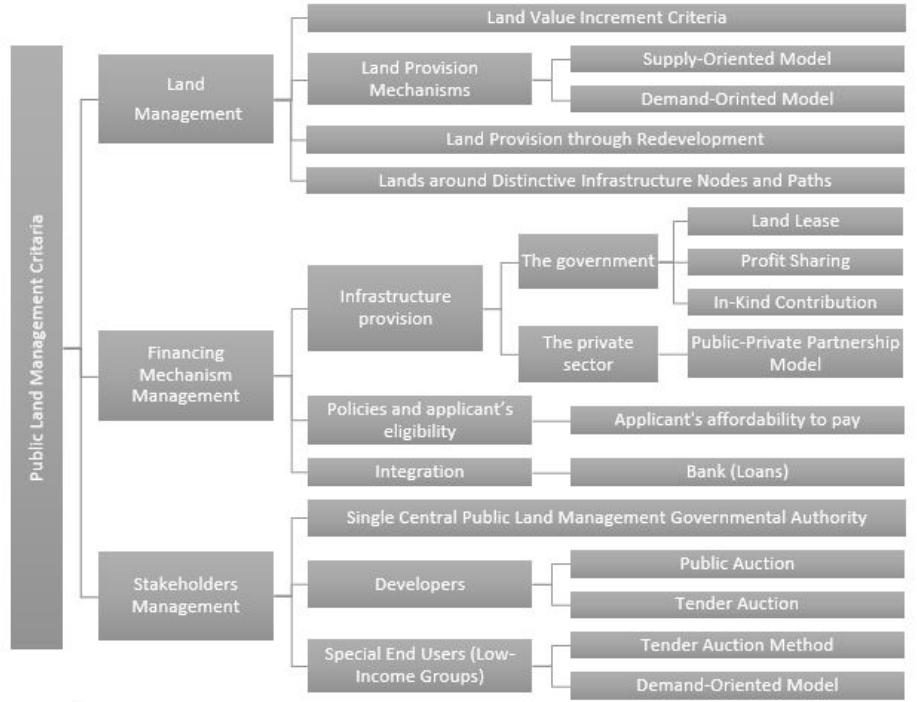
Figure 4. Public Land Management Criteria Summary – Source: